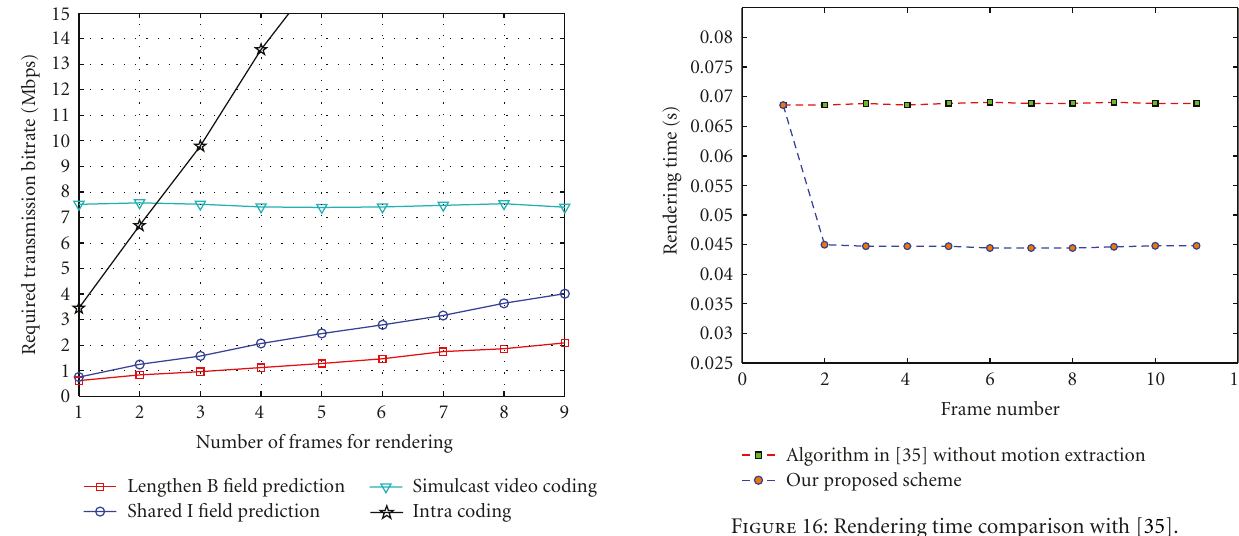
Figure 15: Average required transmission bandwidth changing with the number of views required for rendering. All these schemes deal with the room sequence, with 64 sequences from di ff erent views of camera. For the lengthened-B-field prediction, the interval between the I fields is set to 120, and the number of successive B fields between 2 P fields (or an I field and a P field) is set to 30. For the shared I field coding scheme, the interval between I fields is set to 120.